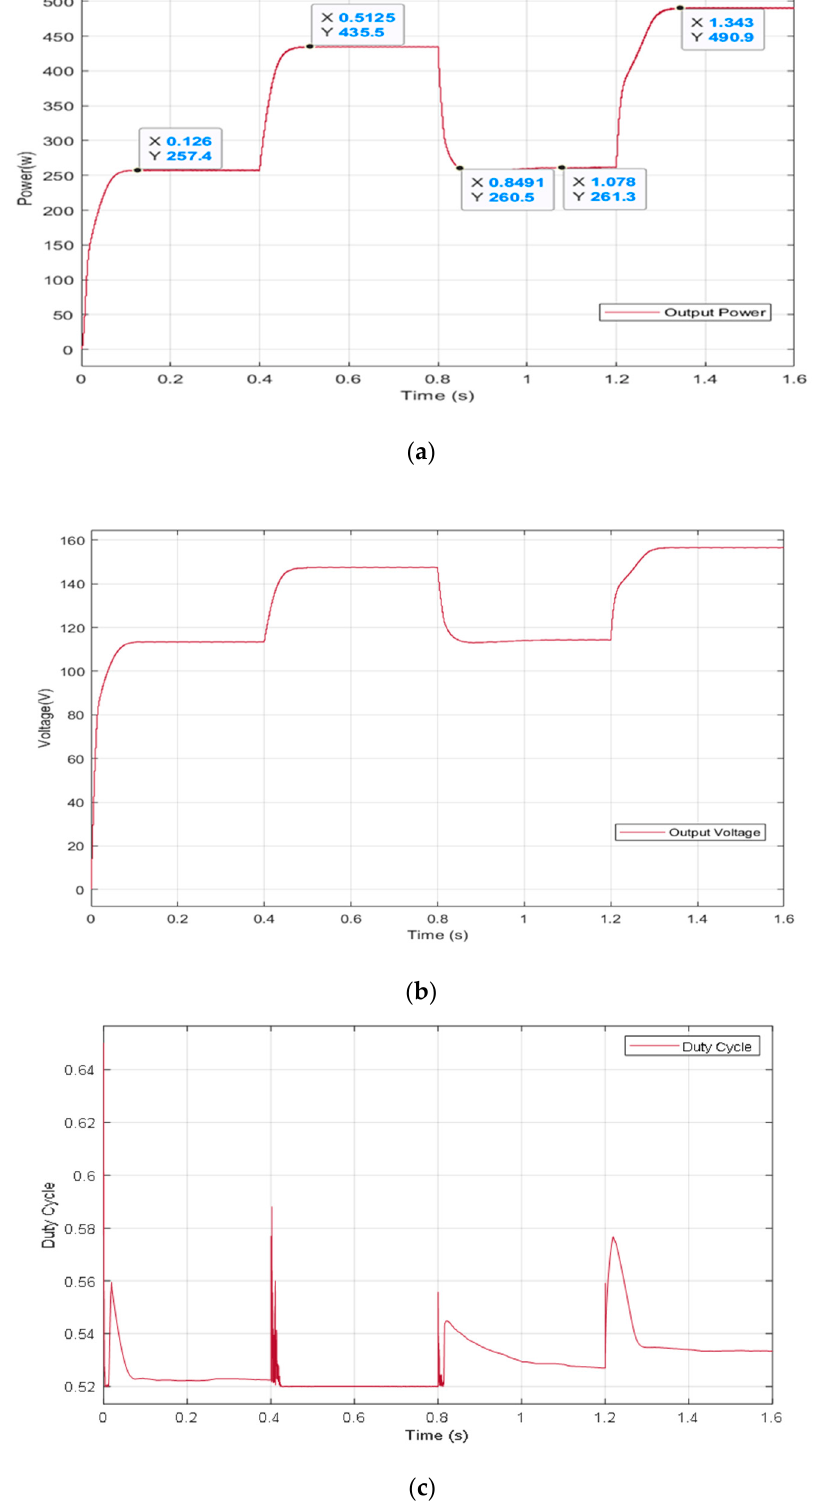
Figure 15. Performance of the combined sequence of Cases Three, Two, Four, and One in terms of ( a ) the output power, ( b ) the output voltage, and ( c ) the duty cycle.